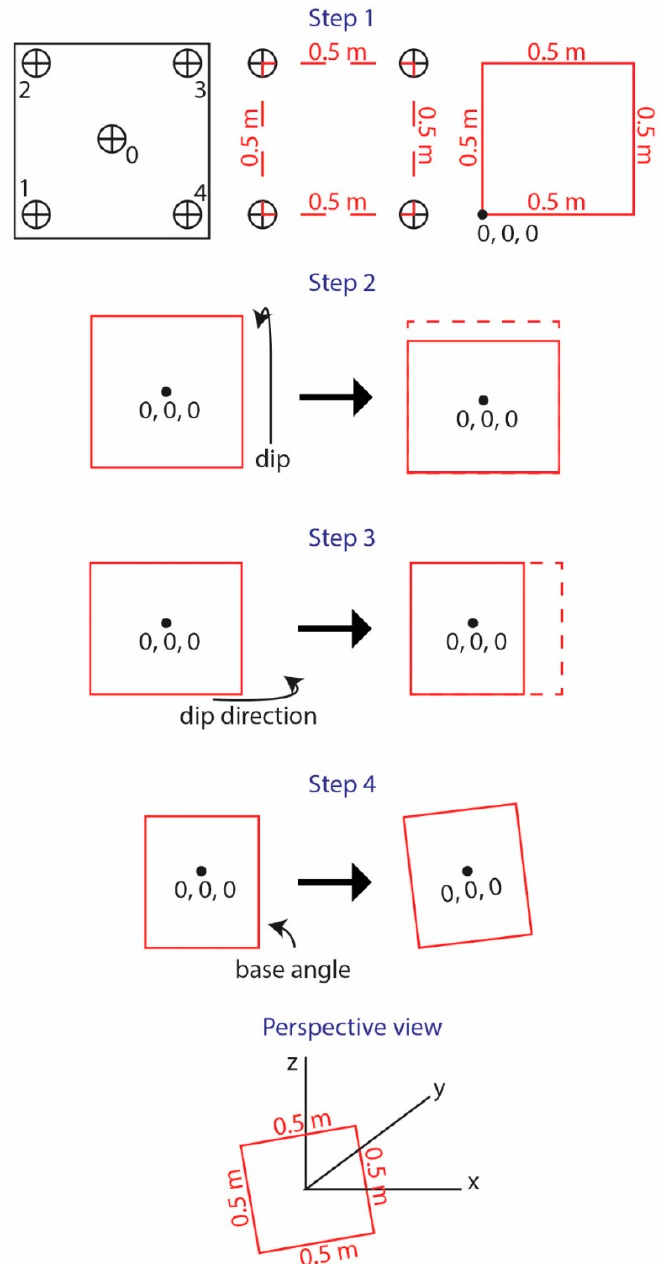
Figure 3. The four steps required to determine the coordinates of the targets using 3D CAD